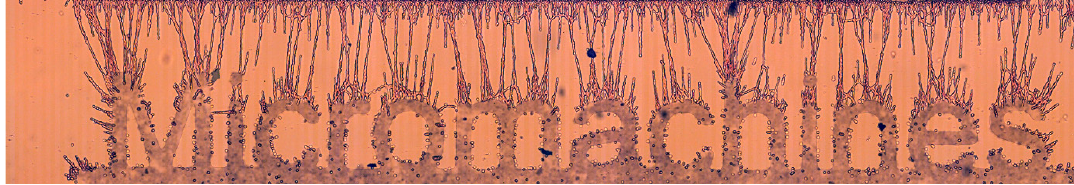
Figure 4. Optical image of the cracks generated directly after dipping the wafer in acetone, after copper deposition. The full Cu film peels off from the substrate and the rGO under the Cu film is detached with it from the COC substrate.